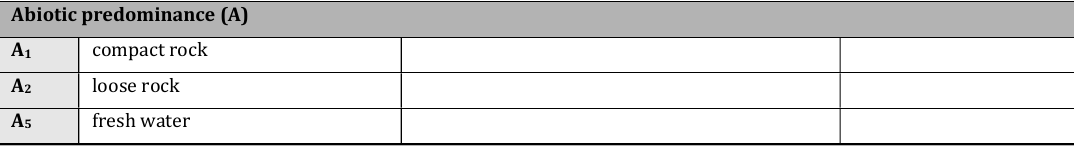
Table 2: Level I landscape classes. Note: A stands for abiotic predominance of elements; B for biotic; and C for cultural. Principal predominance (>50%) is shown in capital letters, secondary predominance (50%-20%) in lower case letters, and significant presence (<20%) in